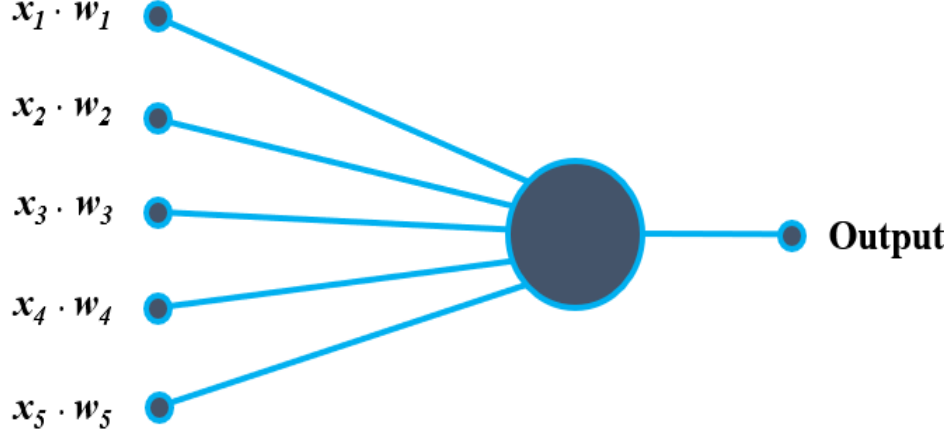
Figure 12. Structure of neurons of the network.